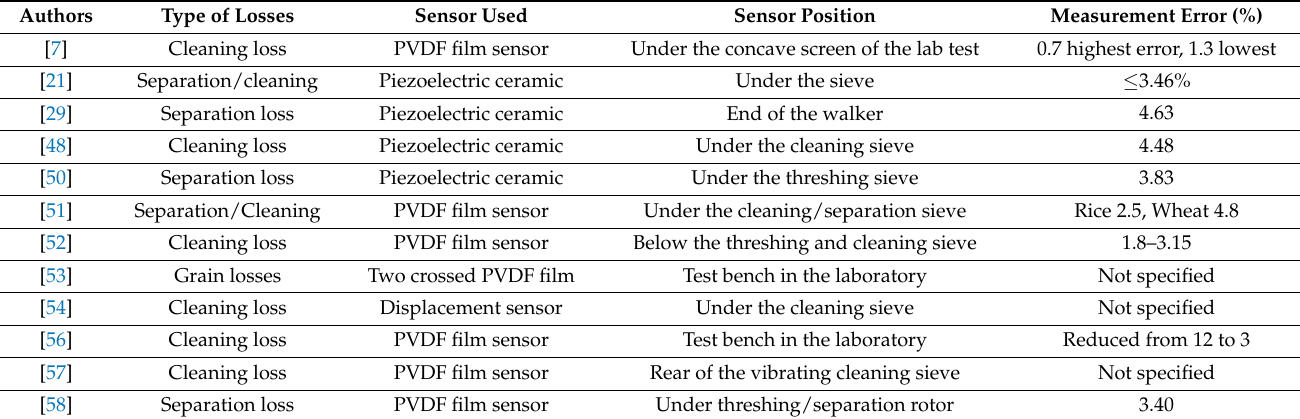
Figure 21. Experimental test bench of grain/MOG falling on the sensor plate [7].